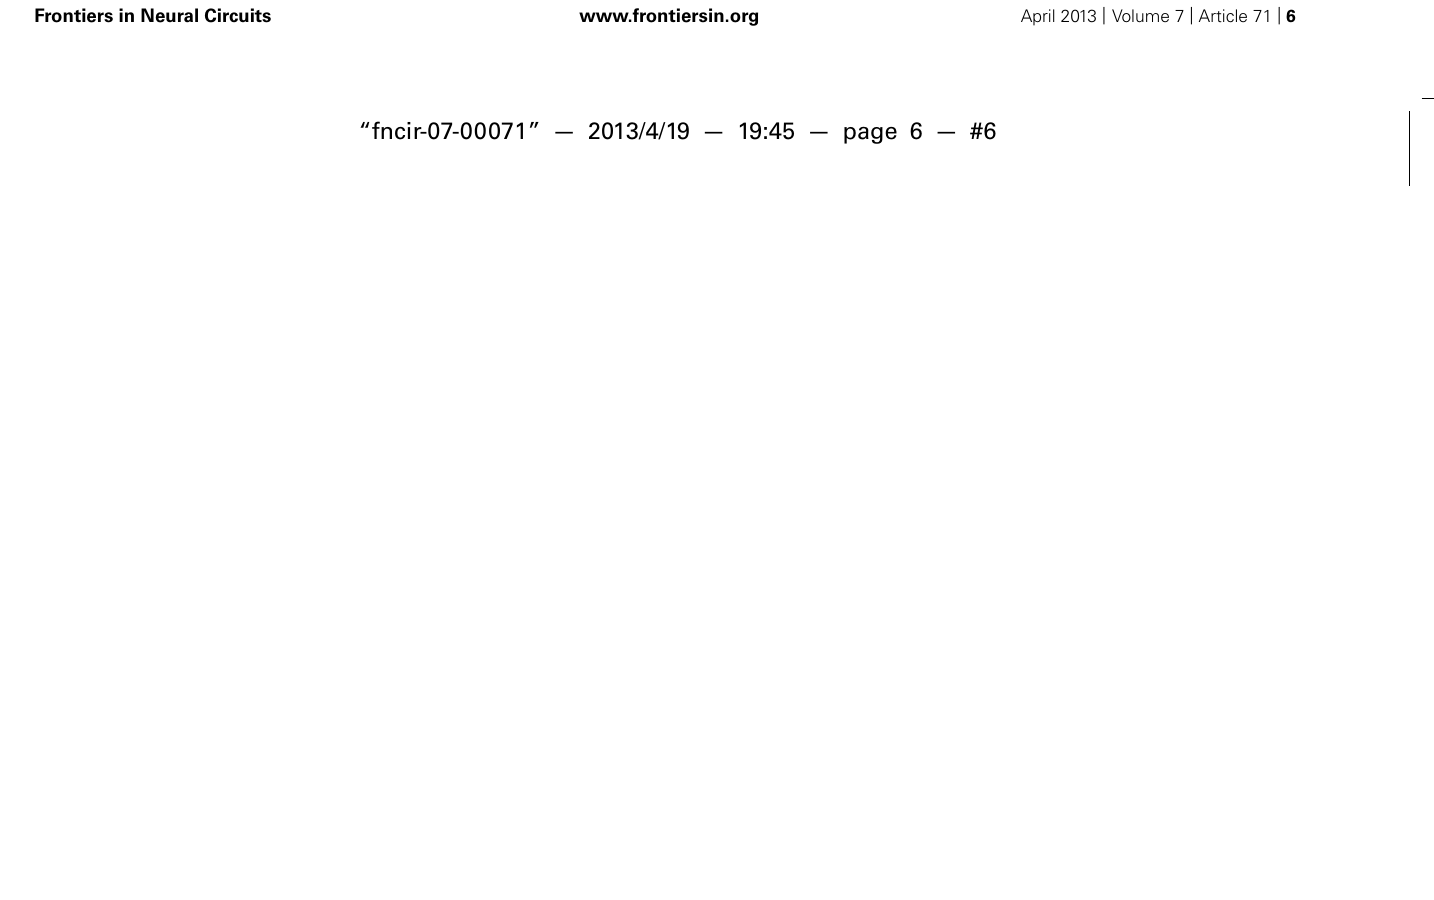
FIGURE 1 | Exhaustive reconstruction of neurons in the olfactory bulb of a zebrafish larva by serial block face scanning EM (SBEM). Shown are skeleton reconstructions of 137 neurons associated with different developing glomeruli (protoglomeruli) in the OB of a zebrafish larva (four days post-fertilization). Somata are transparent to enhance visibility of neurites. Each neuron has been manually reconstructed by three